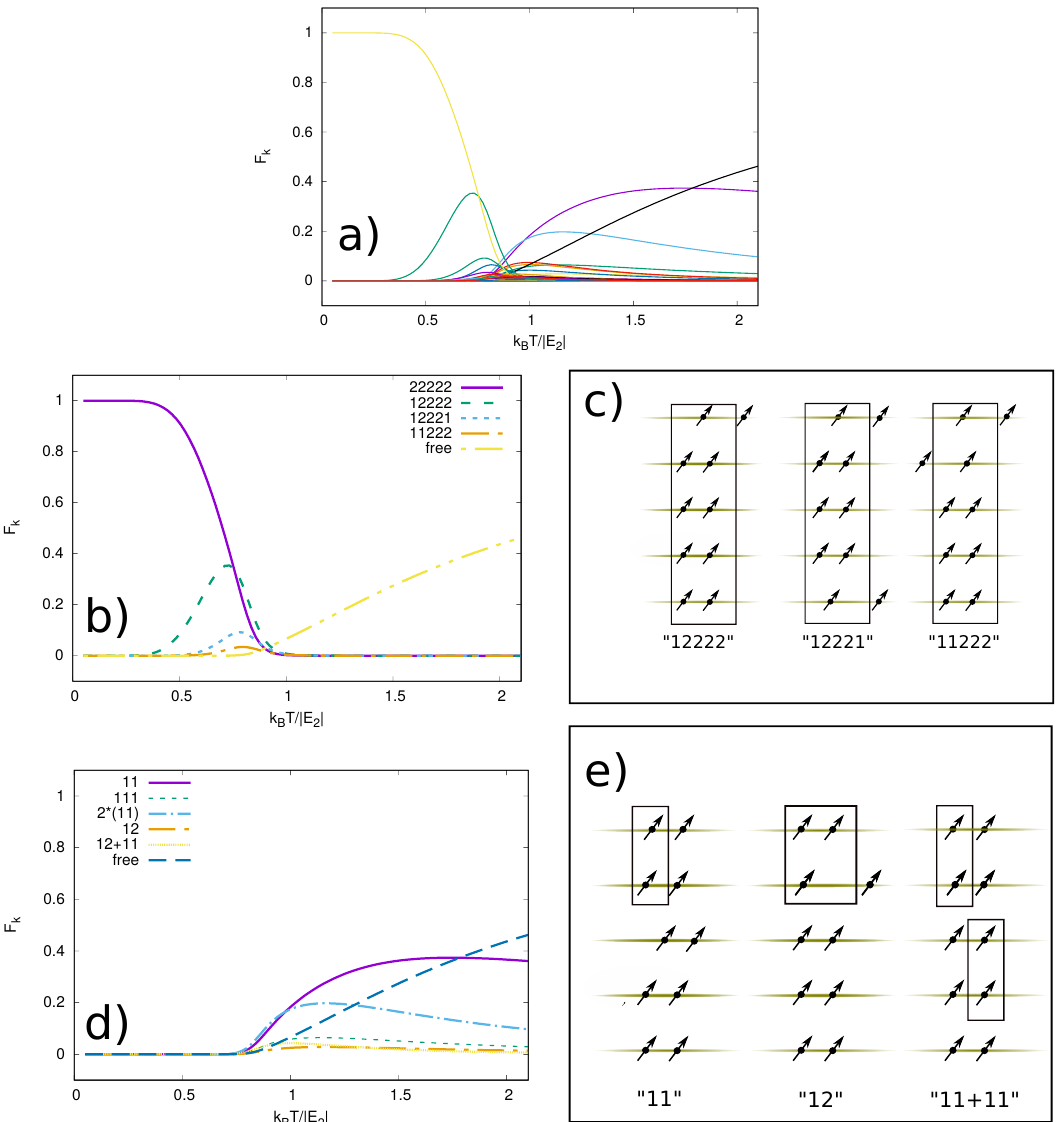
Figure 8. ( a ) Fractional occupancies of all the clusters as a function of temperature for a system of five 1D layers each with two particles. The dipole strength is U = 5, and the confining frequency is chosen such that the oscillator length in the tubes is equal to twice inter-layer distance. The clusters are labeled by their layer occupancy, so a cluster consisting of one particle each in adjacent layers would be labeled ’11’. ( b ) Fractional occupancies of the most populated of the most bound clusters as a function of temperature for a system of five 1D layers each with two particles. The dipole strength is U = 5, and the confining frequency is chosen such that the oscillator length in the tubes is equal to twice the inter-layer distance. Pictures of the clusters can be seen in ( c ). ( d ) Fractional occupancies of the least bound clusters as a function of temperature for a system of five 1D layers each with two particles. The dipole strength is U = 5, and the confining frequency is chosen such that the oscillator length in the tubes is equal to twice the inter-layer distance. ( e ) Pictures of the different smaller clusters with the lowest binding